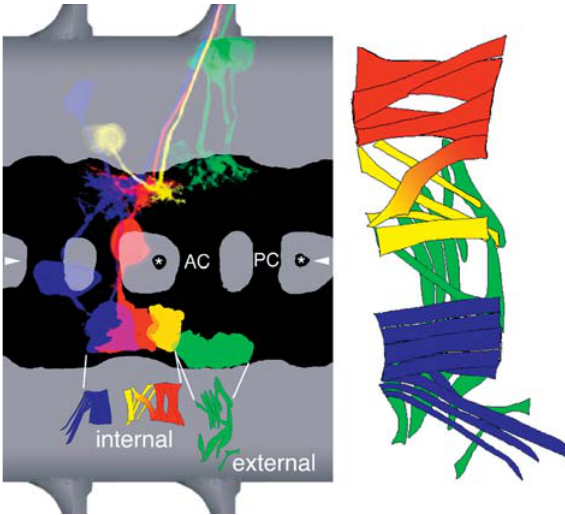
Figure 3. Motor Neuron Dendrites Form a Myotopic Map of the Muscle Field Collage of superimposed representative motor neurons (of 15-h-old embryos) that innervate the muscles of an abdominal half-segment (shown right). Entire dendritic domains are indicated on the contralateral side. Colour code: blue, ventral internal; yellow, dorso- lateral internal; red, dorsal internal; green, external; black, neuropile; grey, cortex. Anterior is left and (for the muscle diagram) dorsal is up. Symbols and abbreviations: triangles, ventral midline; asterisks, dorsoventral channels (landmarks for the segment borders); AC, anterior commissure; PC, posterior commissure. DOI: 10.1371/journal.pbio.0000041.g003